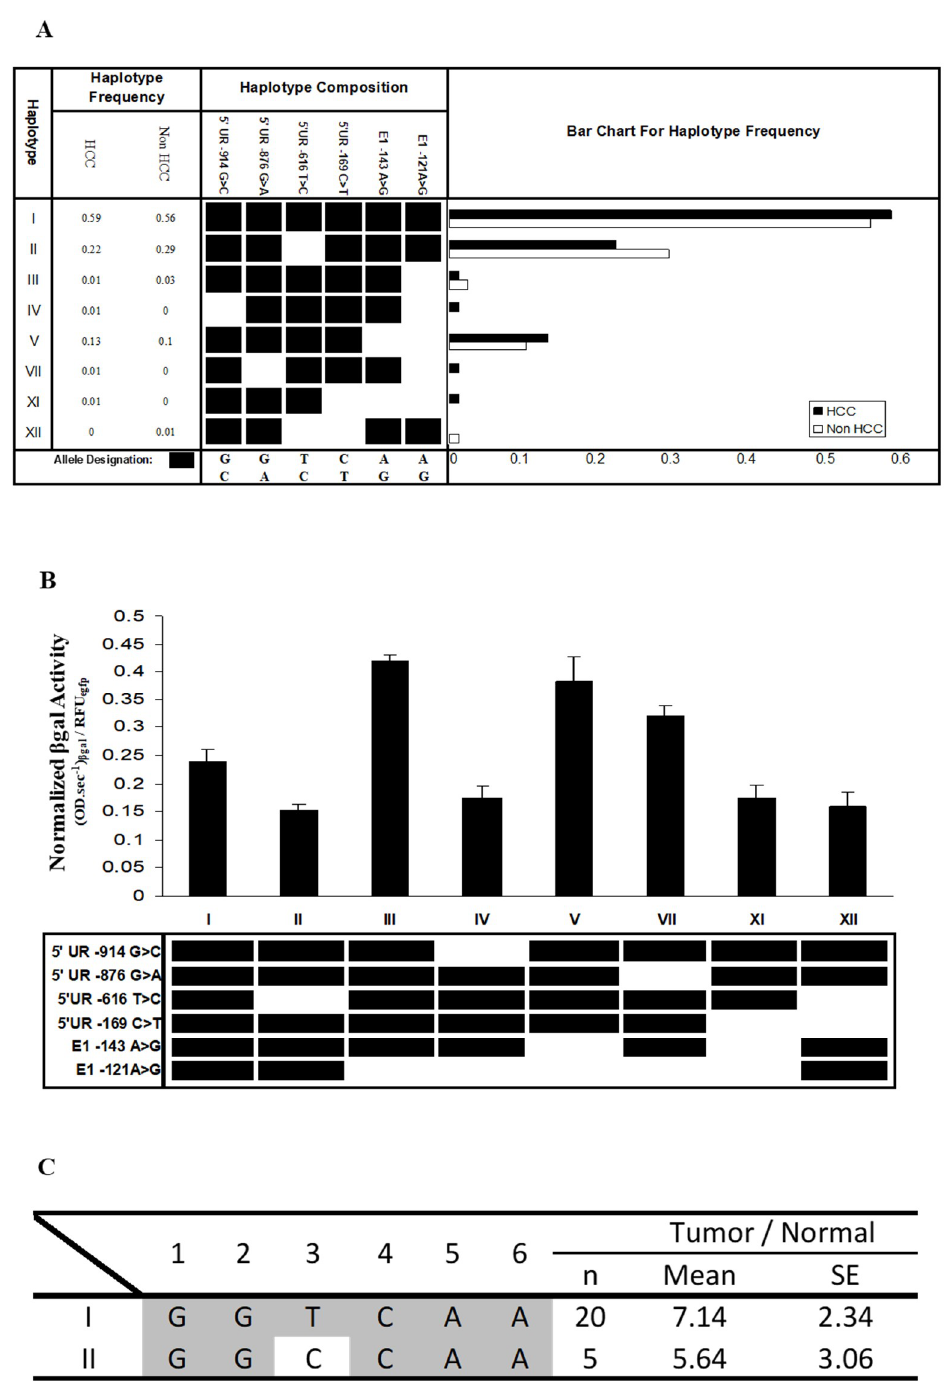
Figure 4. Haplotype of SNPs at the FAT10 promoter region in HCC patients and non‐HCC individuals, and the FAT10 promoter activity mediated by the various haplotypes. ( A ) The frequencies of the haplotype of SNPs at the FAT10 promoter region, as predicted in silico. HCC: hepatocellular carcinoma patients, non‐HCC: individuals of a similar age who have not been diagnosed with HCC; ( B ) Normalized β‐galactosidase activity of the various FAT10 promoters carrying the different haplotypes in Hep3B cells. Data represent the mean and standard errors from four independent experiments. ** denotes significant difference ( p < 0.01) between the various FAT10 promoter haplotypes and wild‐type haplotype (I); ( C ) Fold difference in the normalized FAT10 transcript expression (as determined using reverse‐transcription, real‐time PCR) in the tumour versus non‐tumorous liver tissues of HCC patients with haplotypes I and II.